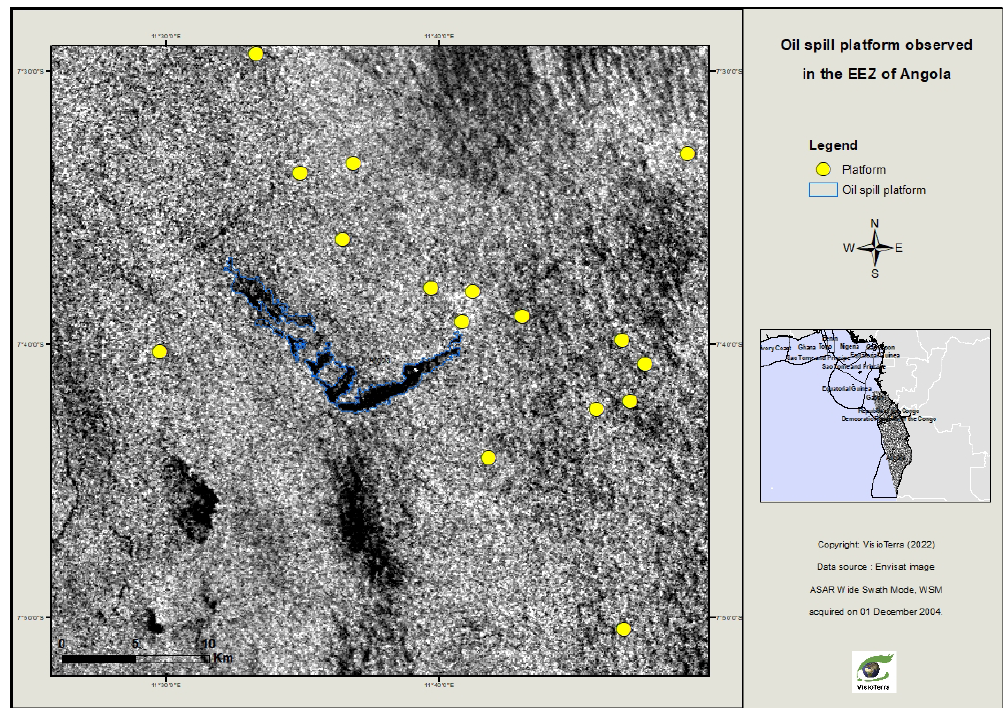
Figure 9. An oil spill from a platform (1 December 2004) observed in the EEZ of Angola. The platforms are represented by the yellow dots.